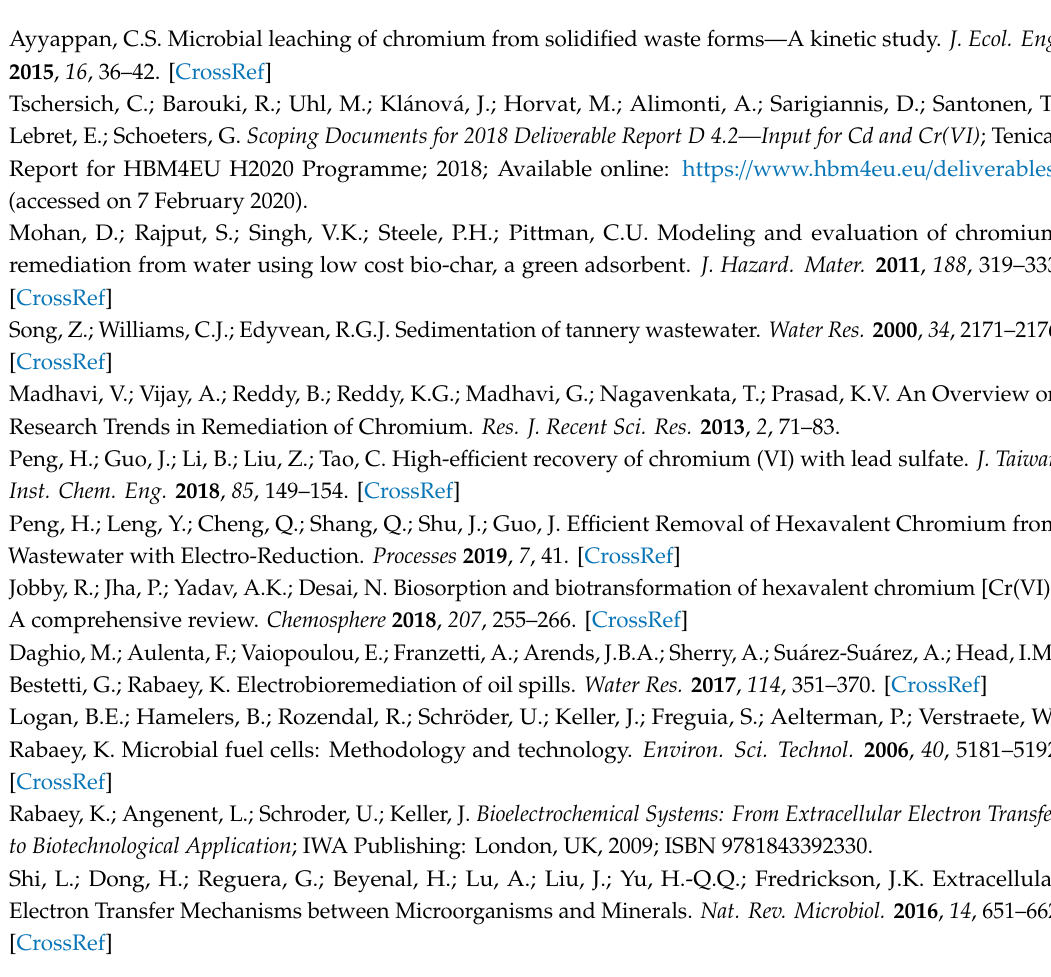
Figure S1: Rarefaction curves of bacterial communities based on OTUS, from the following reactors: t0 Ph. I, t0 Ph. II, POL − 0.3 V electrode, POL − 0.3 V, OC graphite, OC; Table S1: Species richness and diversity